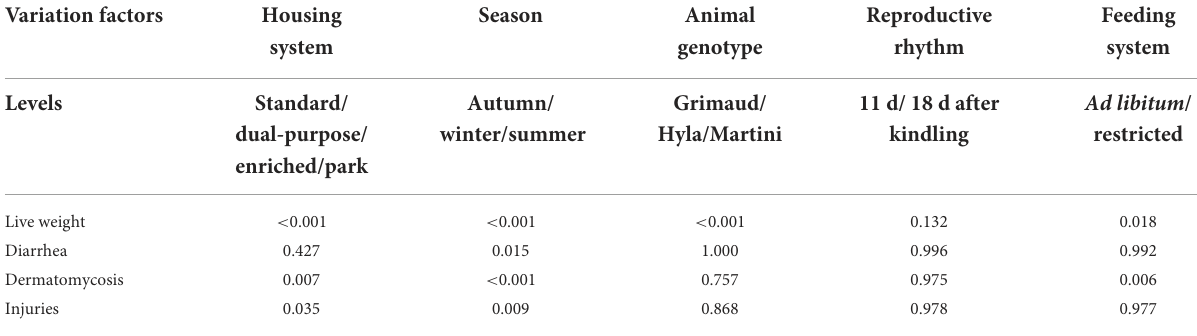
TABLE 7 Risk factors ( P-values ) for animal-based measures in growing rabbits at the pre-slaughtering visit in farms with different housing systems across three seasons. Variation